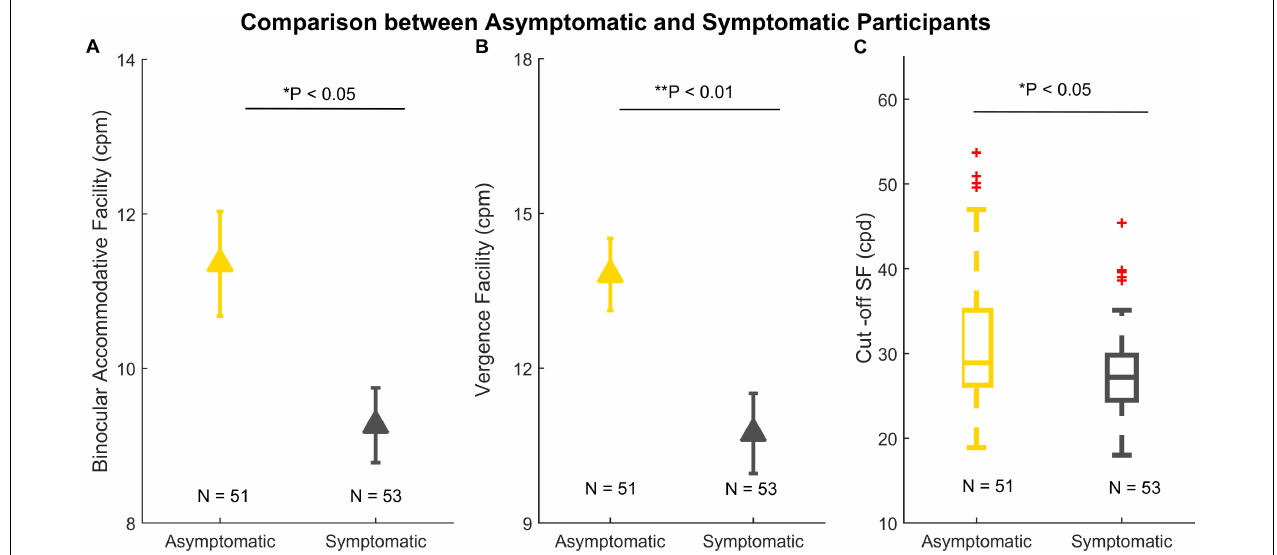
FIGURE 4 | Comparison between asymptomatic ( N = 51) and symptomatic participants ( N = 53). (A) Binocular accommodative facility. (B) Vergence facility. (C) A boxplot of Cut-off SF. In panels (A) and (B) , the error bars denote standard errors. In panel (C) , the line within each box is the median. The box spans the interquartile range (Q1 and Q3). The whiskers represent 1.5 × interquartile above the upper quartile (Q3) and below the lower quartile (Q1). The red crosses outside the whiskers are outliers. * p < 0.05; ** p < 0.01.